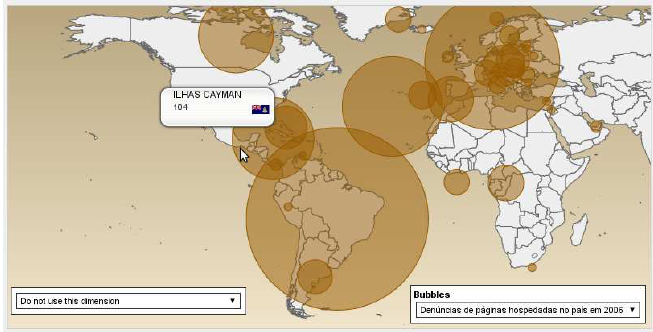
side of the chart will provide a detailed view of a subset of this dataset.